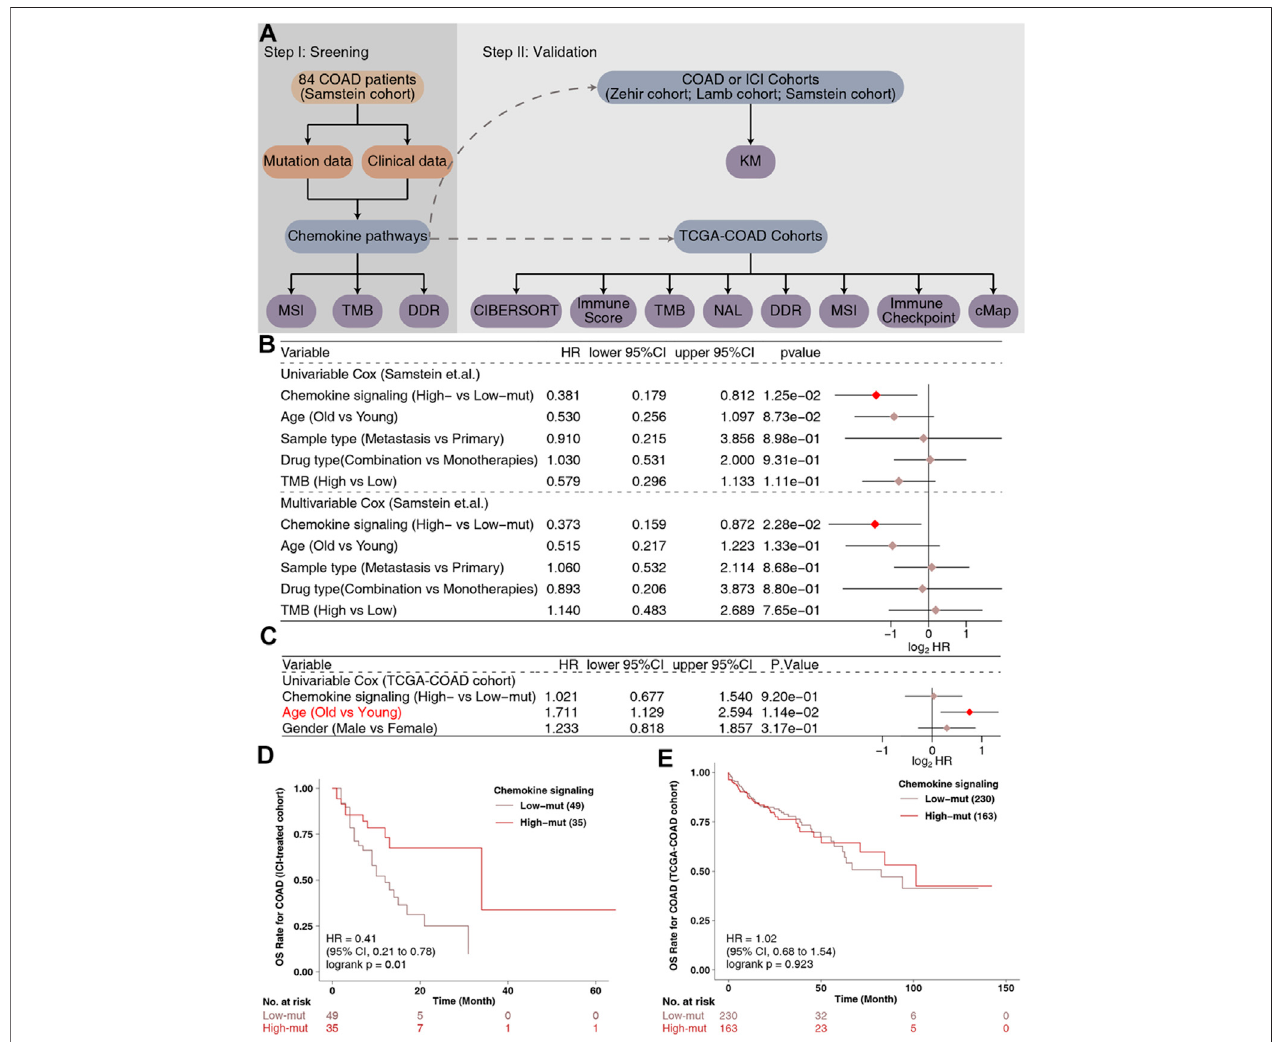
FIGURE 1 | The predictive value of clinical characteristics and the mutation status of the chemokine signaling pathway in terms of ICI ef fi cacy. (A) Flowchart of the data processing in thisstudy. Forest plot ofthe results ofthe Univariate and Multivariate Coxregression analyses in the (B) ICI-treated cohort (Samsteinet al., 2019) and (C) TCGA-COAD cohort. The main portion of the forest plot presents the hazard ratios (HRs) and 95% con fi dence intervals (95%CIs), and red dots indicate p values < 0.05.TheHRindicateswhetherthefactorsarepredictorsoffavorable(HR < 1)orpoor(HR > 1)outcomes. (D) KMsurvivalcurvesforOSin84COADpatientsfrom the ICI-treated cohort (Samstein et al., 2019). (E) KM survival curves for OS in 393 COAD patients from the TCGA-COAD cohort.